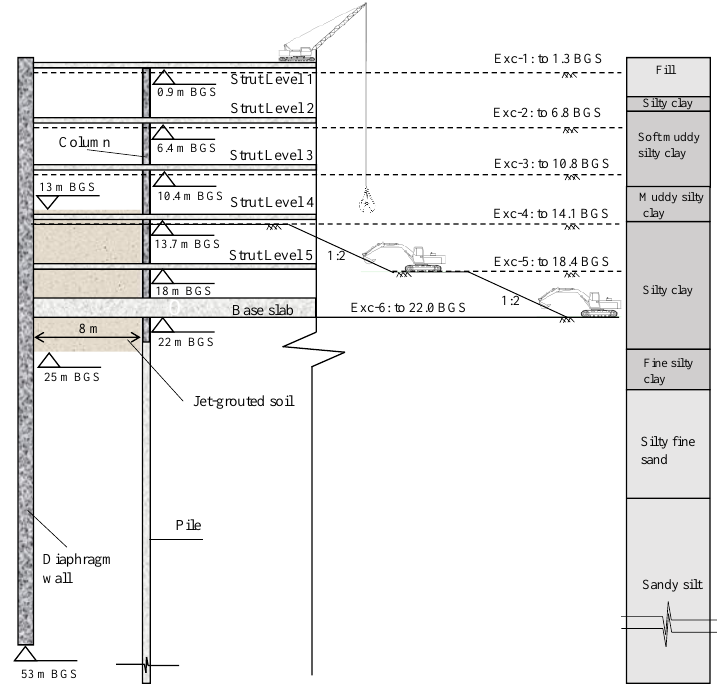
Figure 2. A typical cross section of the Jimo project.